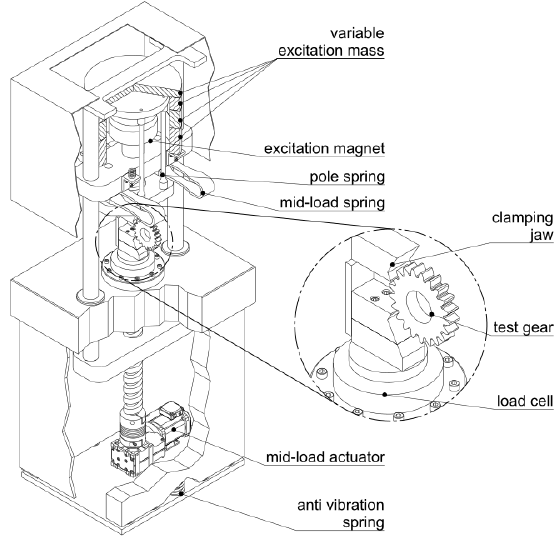
Figure 2. Pulsator test rig (schematic) adopted at FZG [36].